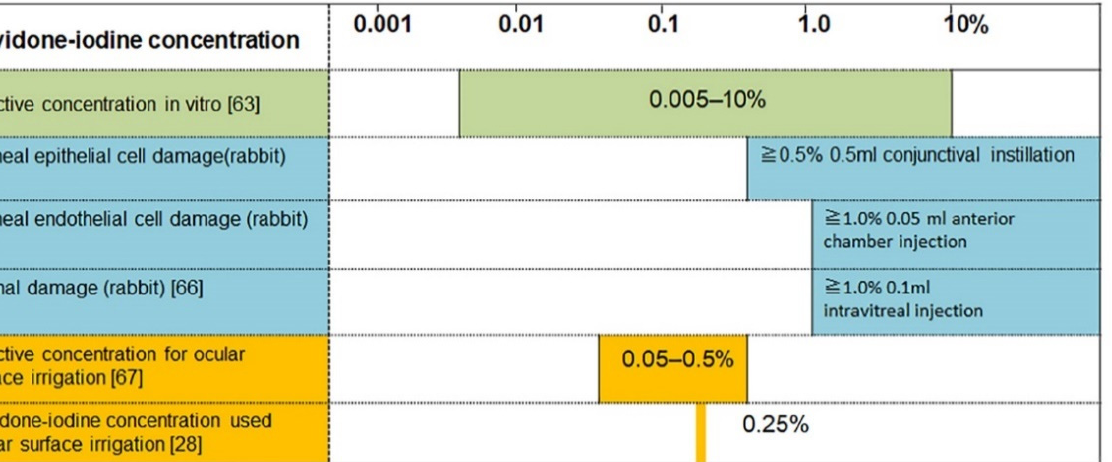
Figure 8. Preparation and use of 0.25% povidone-iodine. ( A ) Inject an appropriate volume of 5% or 10% povidone-iodine into a 250-mL saline bottle to prepare a 0.25% solution, and attach a cleaning needle to the cap. This can also be used to clean the ocular surface before surgery. ( B ) Dispense the solution from the bottle into a cup placed on the operating table, put a syringe in the cup and use during cataract surgery. (Modified from [69]). The color of povidone-iodine reflects the amount of effective iodine [69]. A 5–10% solution is dark brown, a 0.25% solution is brown and a 0.025% solution is light brown. When 0.25% povidone-iodine in an open container is left at room temperature, it decolor- izes over time. When 0.25% povidone-iodine in a closed container is placed at room tem- perature for 60 min, there is no decolorization and no loss of bactericidal effect. When